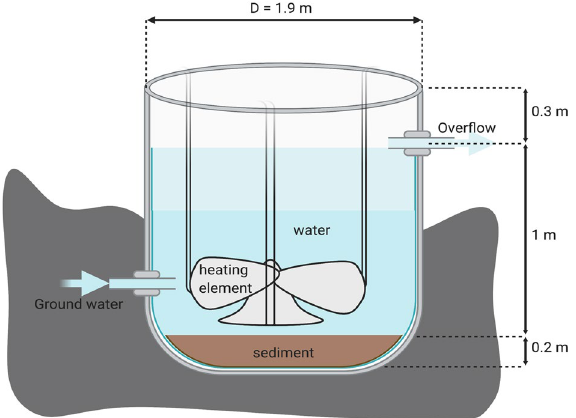
Figure 1. An image of one of the 24 flow-through tanks in the LMWE experiment run at the experimental facility belonging to Aarhus University, Denmark (modified from 42 ). The collection tank was placed at right side (not included). This image was created with BioRender (https:// biore nder.